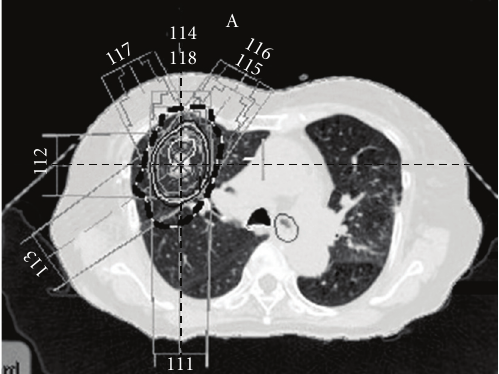
Figure 2: Dose distribution of treatment plan. The dashed line indicates the 50% isodose curve.